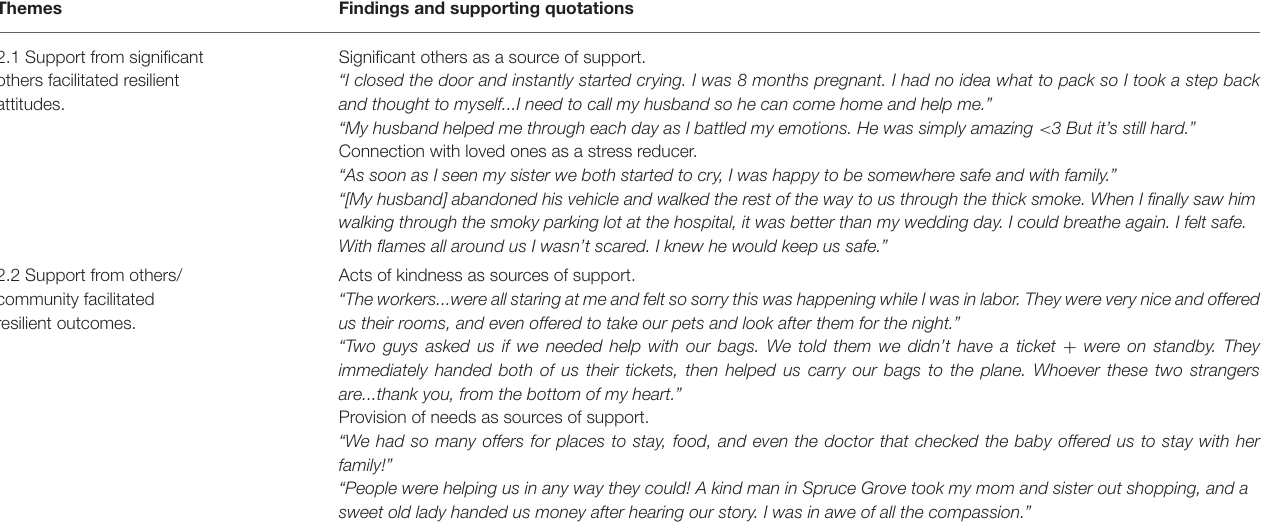
TABLE 2 | Theme 2: Social support was a facilitator of resilience.